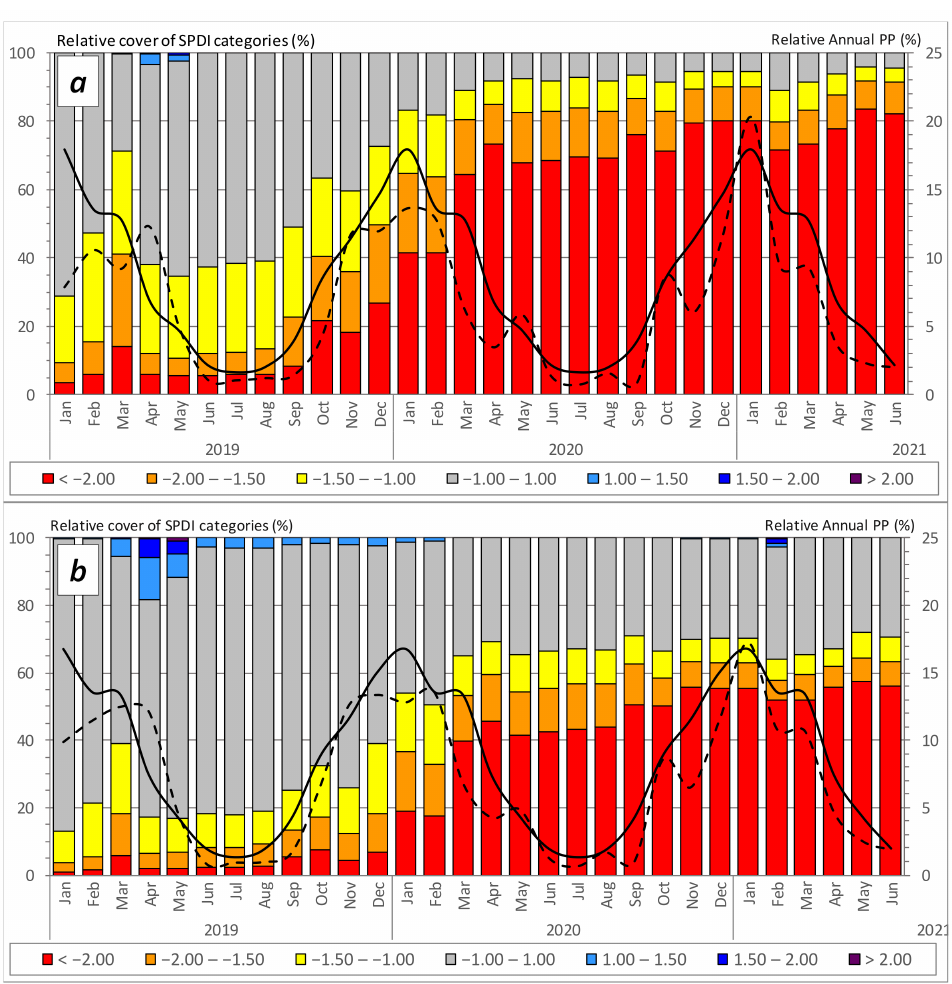
Figure 5. Relative cover (%) of SPDI categories at ( a ) the Pantanal and ( b ) the surrounding Highlands. Categories were adapted from McKee et al. [34] and WMO [37] and correspond to the following SPDI range of values: ≤− 2.0, Extreme drought; − 2.0–1.5, Severe drought; − 1.5– − 1.0 Moderate drought; − 1.0– − 1.0, Near-normal; 1.0–1.5, Moderately wet; 1.5–2.0, Severely wet; and ≥ 2.0, Extremely wet. Solid line is the historical monthly mean precipitation for the climatological series 1981–2010, while the dashed line is the observed amount precipitated. Both lines, expressed as relative to annual precipitation (in